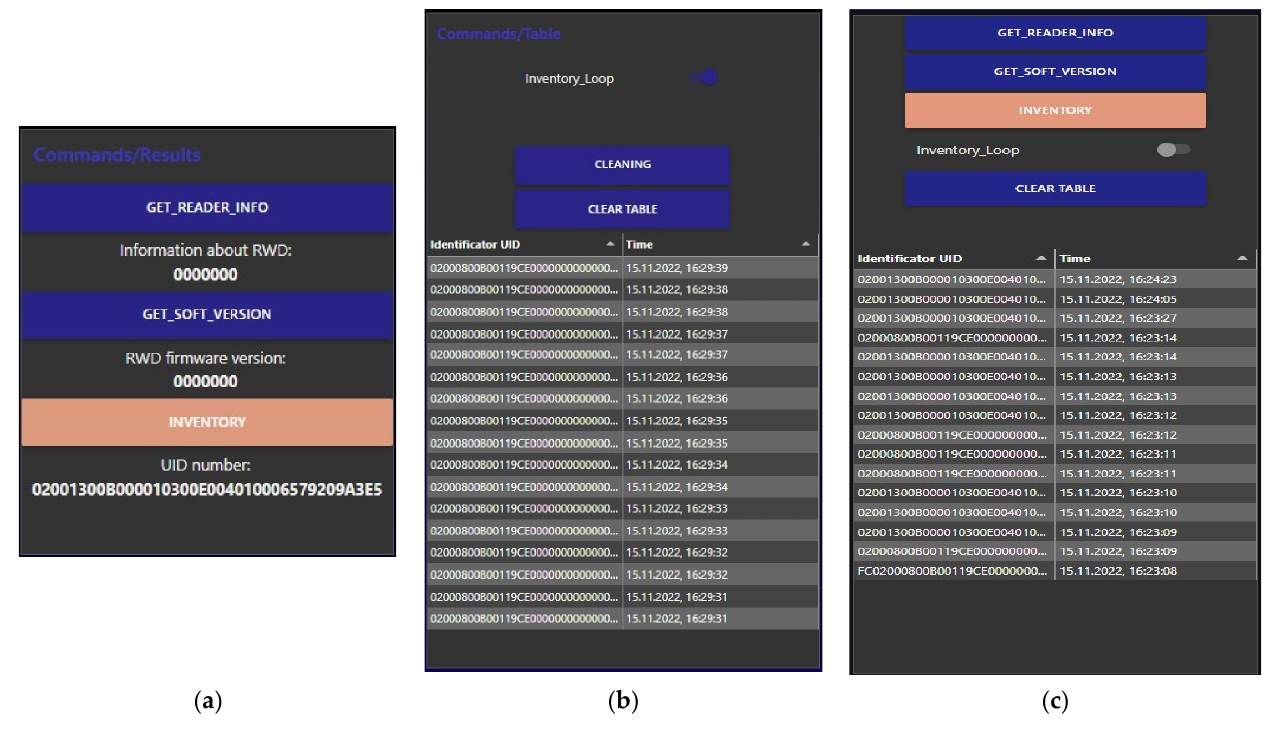
Figure 7. Tests: ( a ) Retrieving RWD system information; ( b ) Identifying RFID objects; ( c ) GUI for mobile devices.